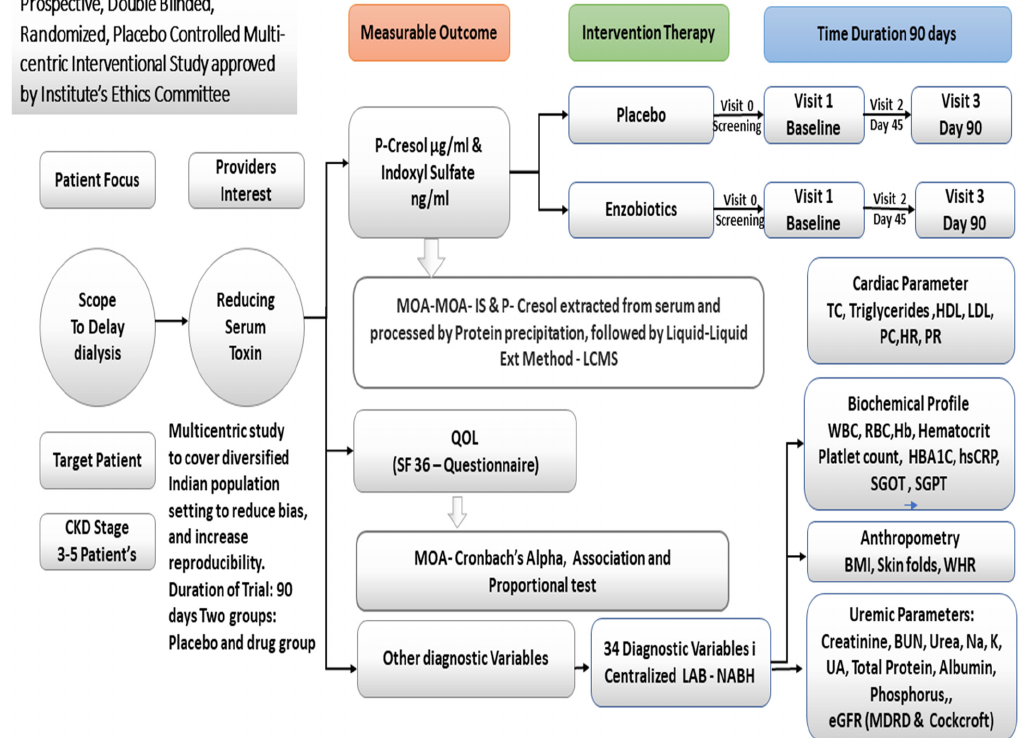
Figure 2. Schema of the Study. MOA, method of analysis; QoL, quality of life; TC, total count; HDL, high-density lipids; LDL, low-density lipids; SGOT/SGPT, serum glutamic–oxaloacetic transaminase; SGPT, serum glutamic–pyruvic transaminase; BUN, blood urea nitrogen; Na, sodium; K, potassium; P, phosphorus; UA, uric acid; PC, platelet count; HR, heart rate; PR, pulse rate; NABH, National Accreditation Board for Hospitals and Healthcare Providers. Diversified Indian population: 85 subjects were recruited from Coimbatore (23 Tamilnadu), Bangalore (25 from Karnataka), Lucknow (30 from Uttarpradesh), and Goa (seven from Goa).